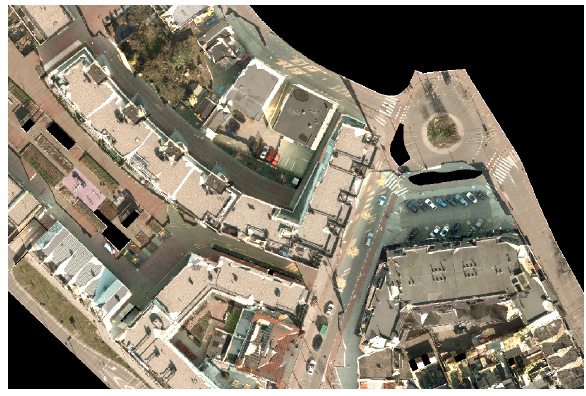
Figure 13: Shading/shadow compensation